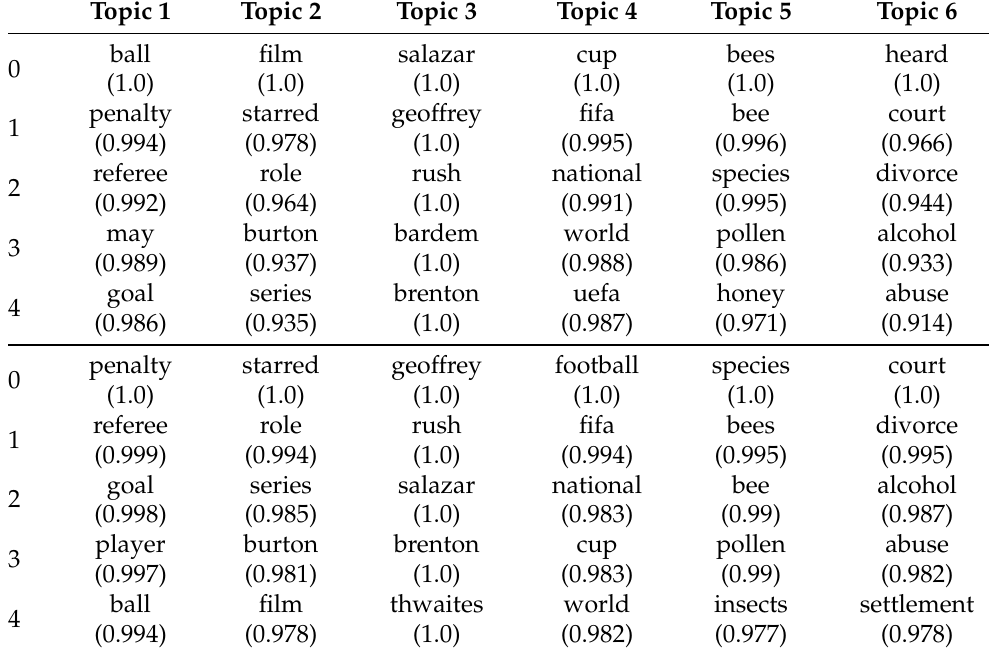
Table 6. For the most significant two words per topic, the four nearest neighbors based on cosine similarity are listed. Matrix A (cid:48) trained on the wikipedia data as input matrix using automatic gradient